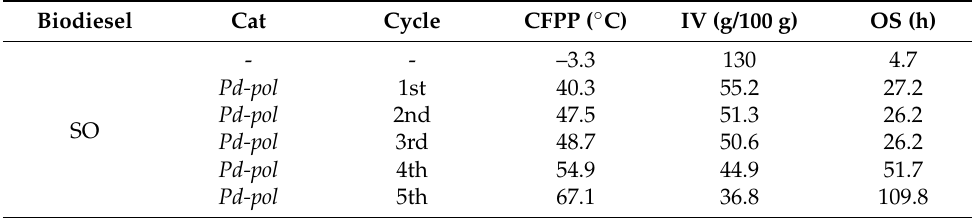
Table 1. CFPP, IV, and OS for SO and WCO diesel samples treated with Pd-pol or Ni-pol catalytic